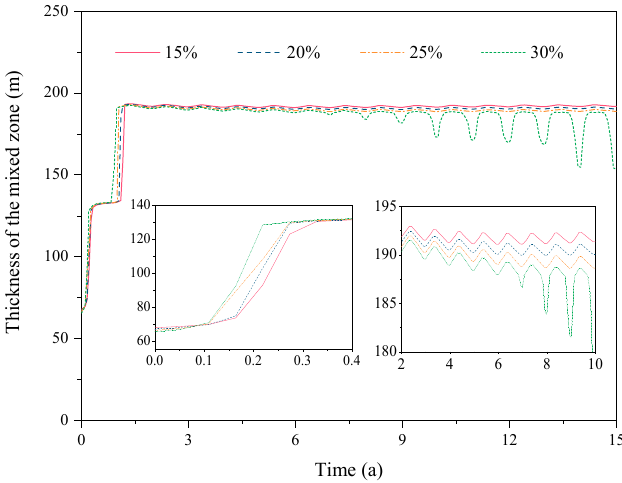
Figure 19. Reservoir average pressure for different residual water saturations.